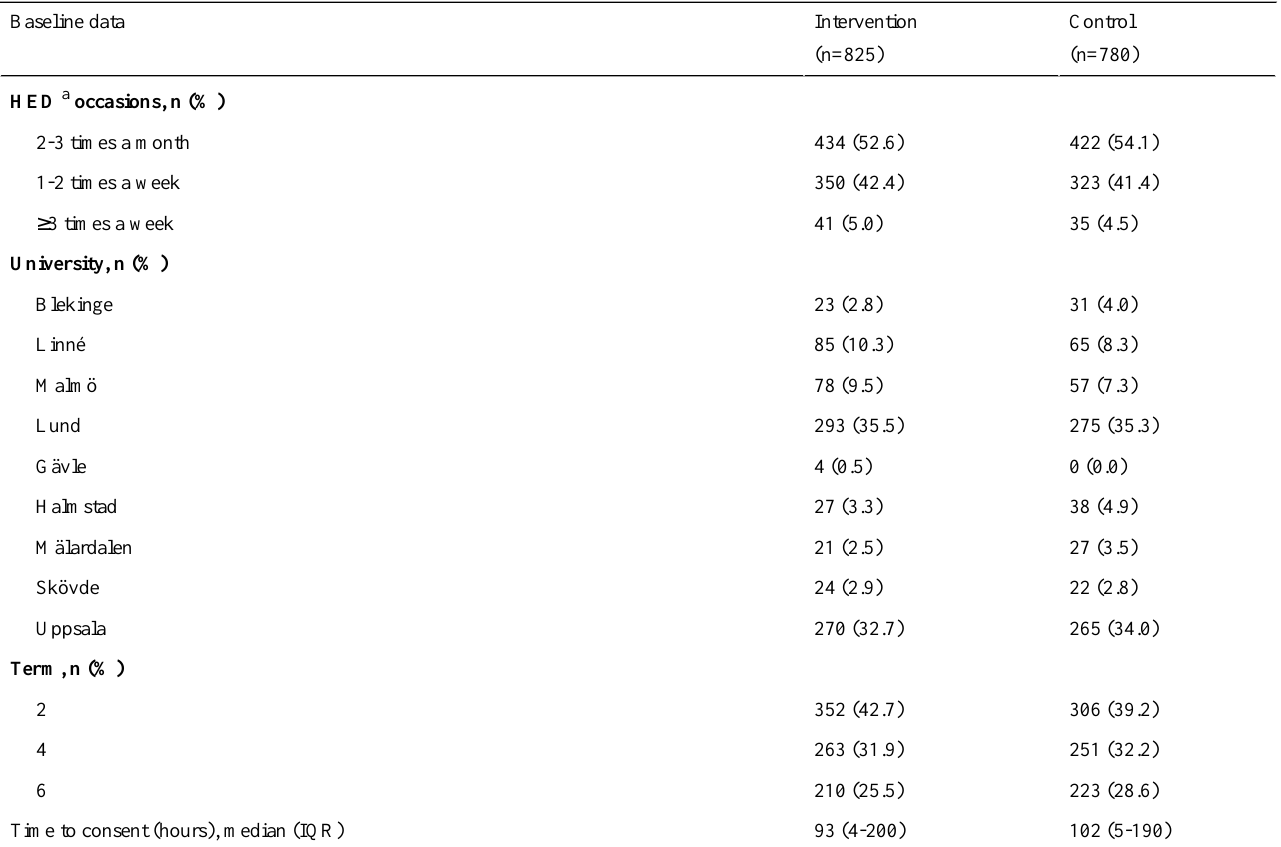
Table 1. Comparison of groups at baseline